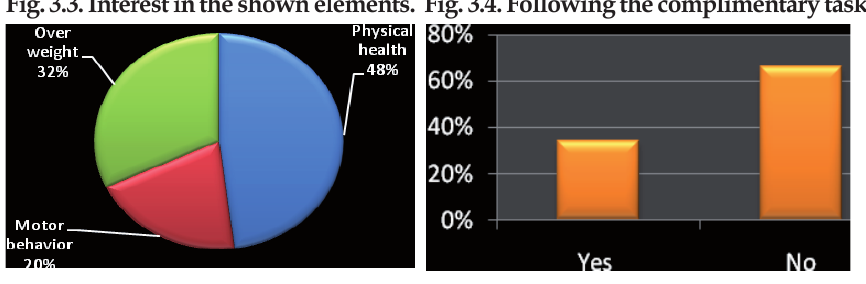
Source: Own chart. Fig.3.5. Restricting factors that hinder partents into realizing the child additional